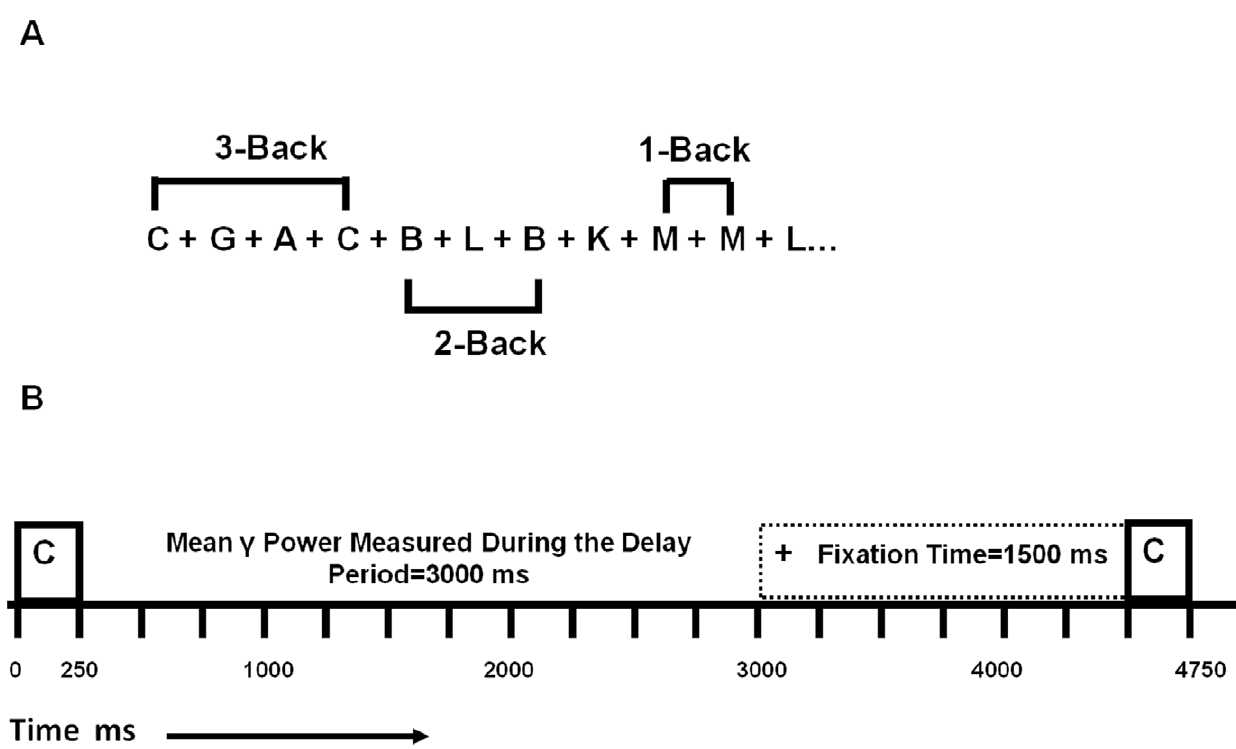
Figure 1. A representation of the 1-, 2- and 3-back conditions that were completed in a randomized order by patients with schizophrenia (SCZ) and healthy subjects (HS) pre-post rTMS. Subjects were required to push one button (target) if the current letter was identical to the letter presented ‘‘N’’ trials back; otherwise the participants pushed a different button (non-target). Correct responses for target (TC) and non-target (NTC) were included in the data analysis (A). The timing of one trial from the presentation of a one letter separated by a ( + ) sign followed by a subsequent letter for a total time of 3000 msec (B).